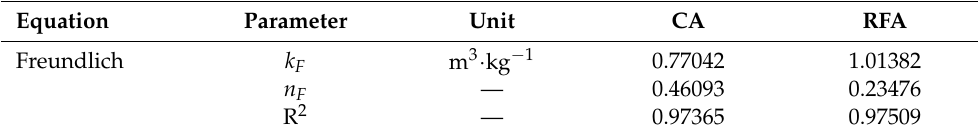
Table A16. Adsorption isotherm parameters for Pt(cod)me 2 from scCO 2 solution at 10.6/10.7 MPa and 308 K on different substrates [10,58].